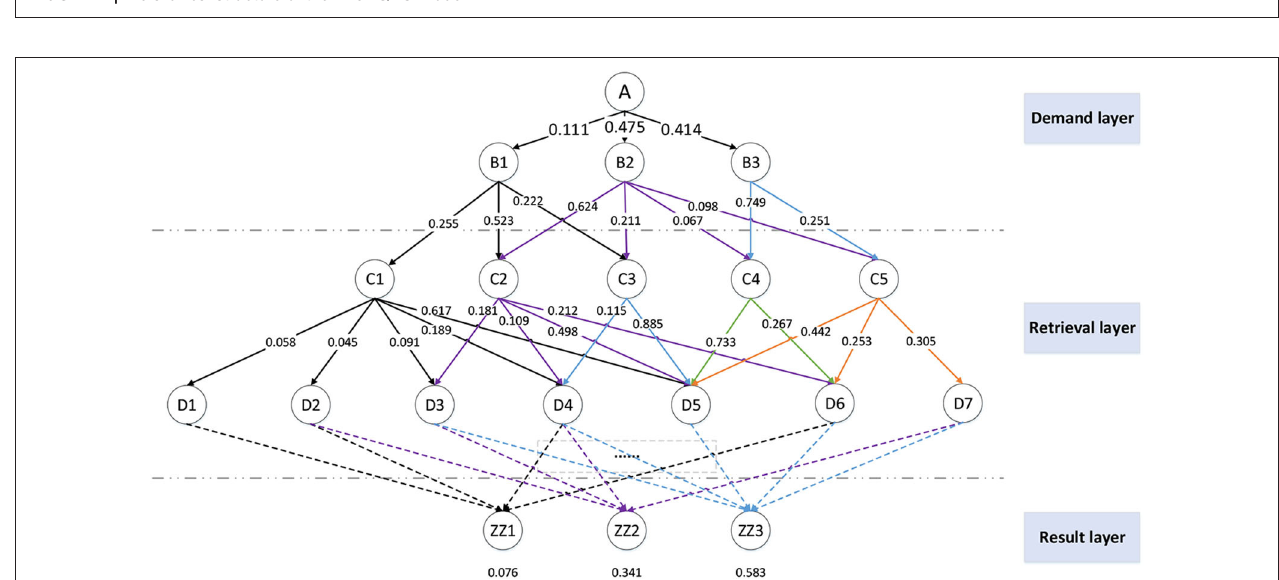
FIGURE 5 | M-3DQKG model retrieval weight calculation and creative library